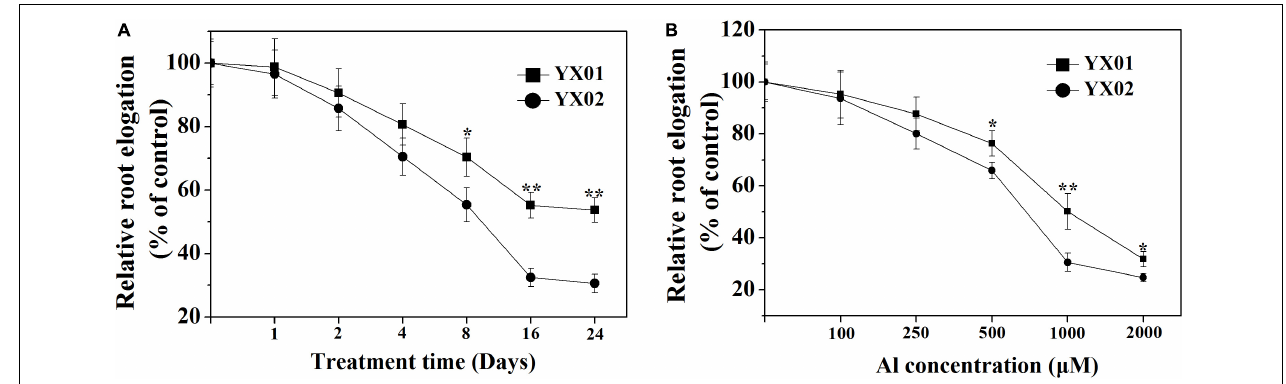
FIGURE 1 | Effects of different aluminum (Al) exposure time (A) and concentration (B) on relative root elongation of Chinese fir seedlings. Two-month-old Chinese fir seedlings were exposed to 1/2 strength complete nutrition solution without Al (CK), or with 1 mM AlCl 3 (Al) for 24 d, or exposed to CK or different concentration Al for 16 d. Bars are means of four replicates ± SD. * or ** above lines represent significant differences at P < 0.05 and P < 0.0 1, respectively.